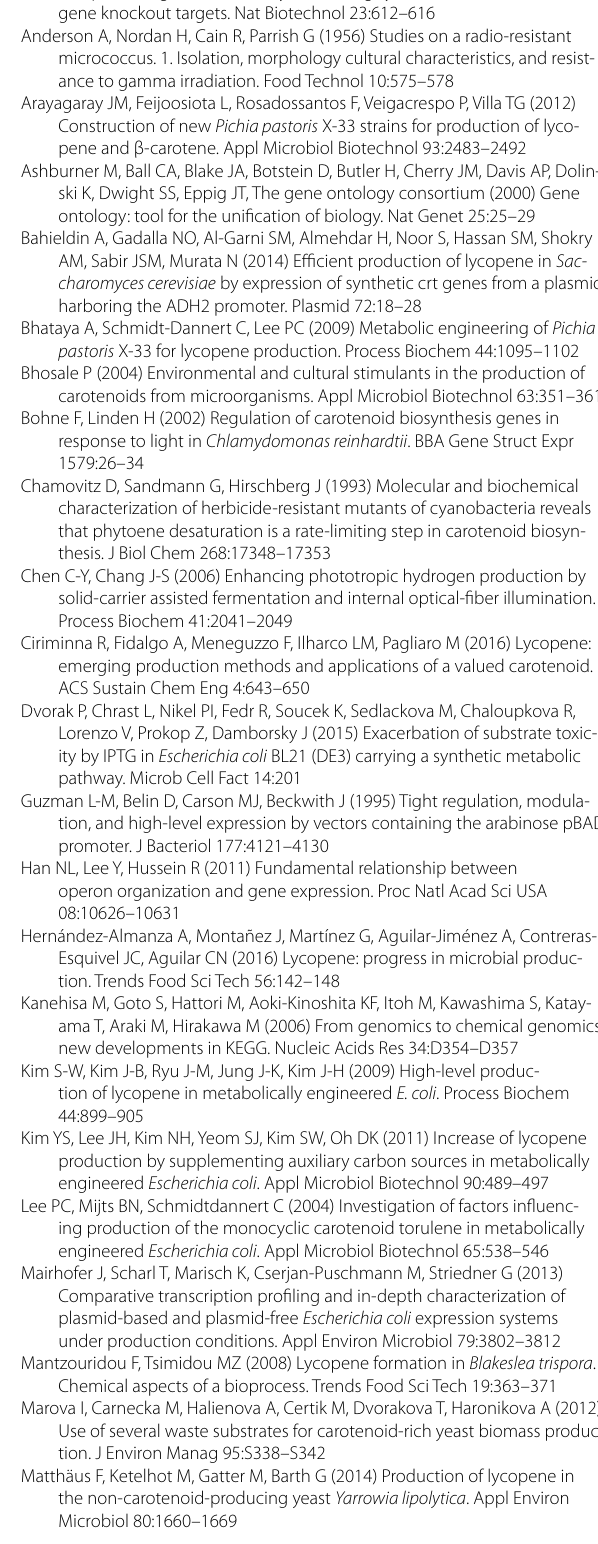
Additional file 1: Figure S1. Gene function annotations of R12 genome in GO, COG and KEGG databases. Figure S2. The antiSMASH analysis results of R12 genome. Figure S3. The orientation and distribution of the carotenoid biosynthetic genes from the R1 and R12. Table S1. Bioinfor- matic analysis of key enzymes of carotenoid biosynthesis in R12. Table S2. Percentages of sequence identity of proteins in carotenoid biosynthesis between D. wulumuqiensis R12 and other Deinococcus spp